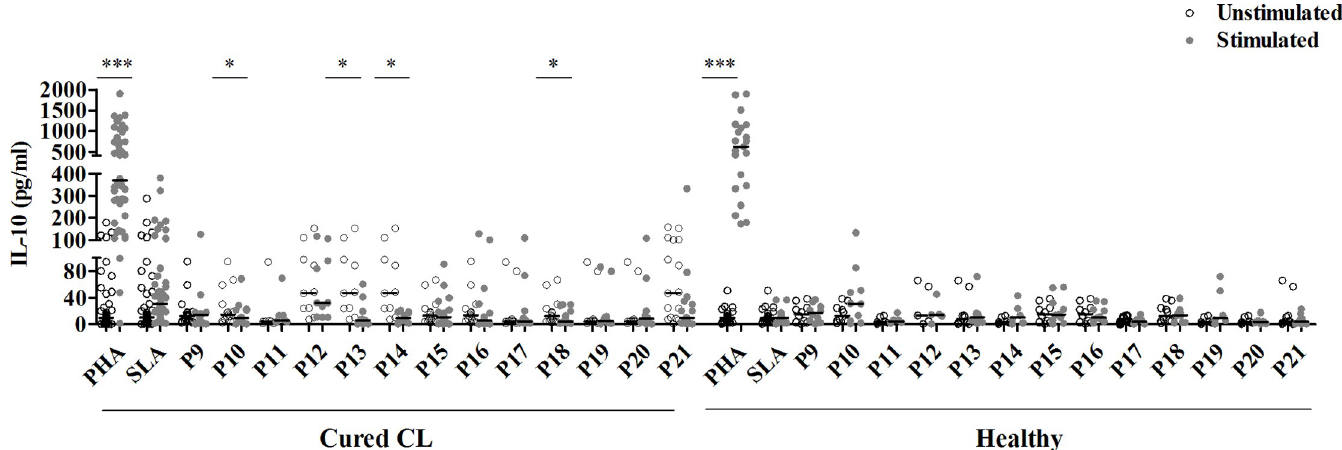
Fig 5. IL-10 responses to pools composed of both HLA-I and HLA-II peptides. IL-10 was quantified by ELISA, in culture supernatants of PBMC from cured CL subjects (N = 16) or healthy individuals (N = 10) stimulated with peptide pools (1 μ M/peptide) composed of both HLA-I and HLA-II peptides, for 10 days. PHA and SLA were used as positive controls (10 μ g/ml). Horizontal bars represent median values. Statistical significance was assigned to a value of p < 0,05 ( � p < 0.05, �� p < 0.01, ��� p <